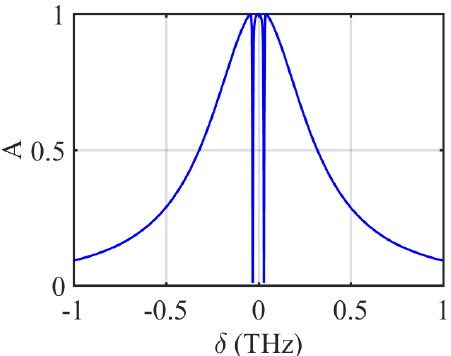
Fig. 8. Absorption of a system with three cavities. The simulation parameters are set as Q L ; 1 ¼ 5 (cid:5) 10 4 , Q L ; 2 ¼ 1 (cid:5) 10 8 , Q L ; 3 ¼ 1 (cid:5) 10 8 , Q i ¼ 2 (cid:5) 10 3 , and Q c ; 1 ¼ Q c ; 2 ¼ Q c ; 3 ¼ 2 (cid:5) 10 4